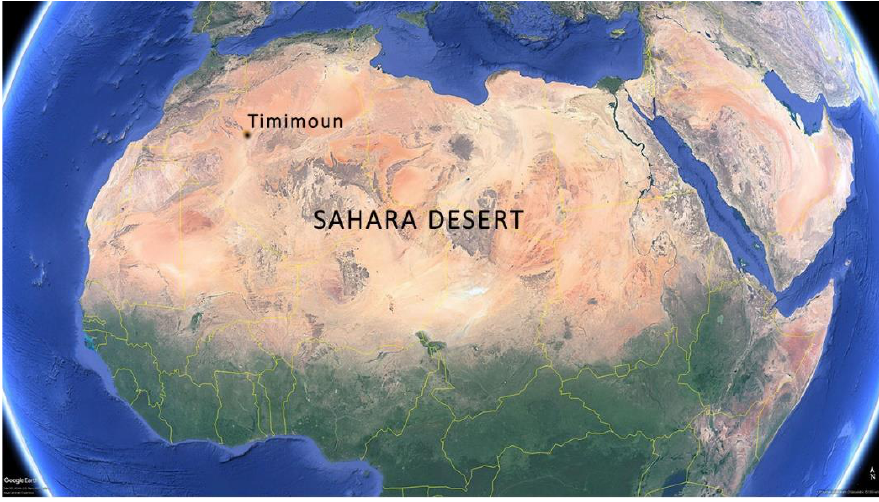
Figure 1 The Satellite image of African Sahara Desert (Google